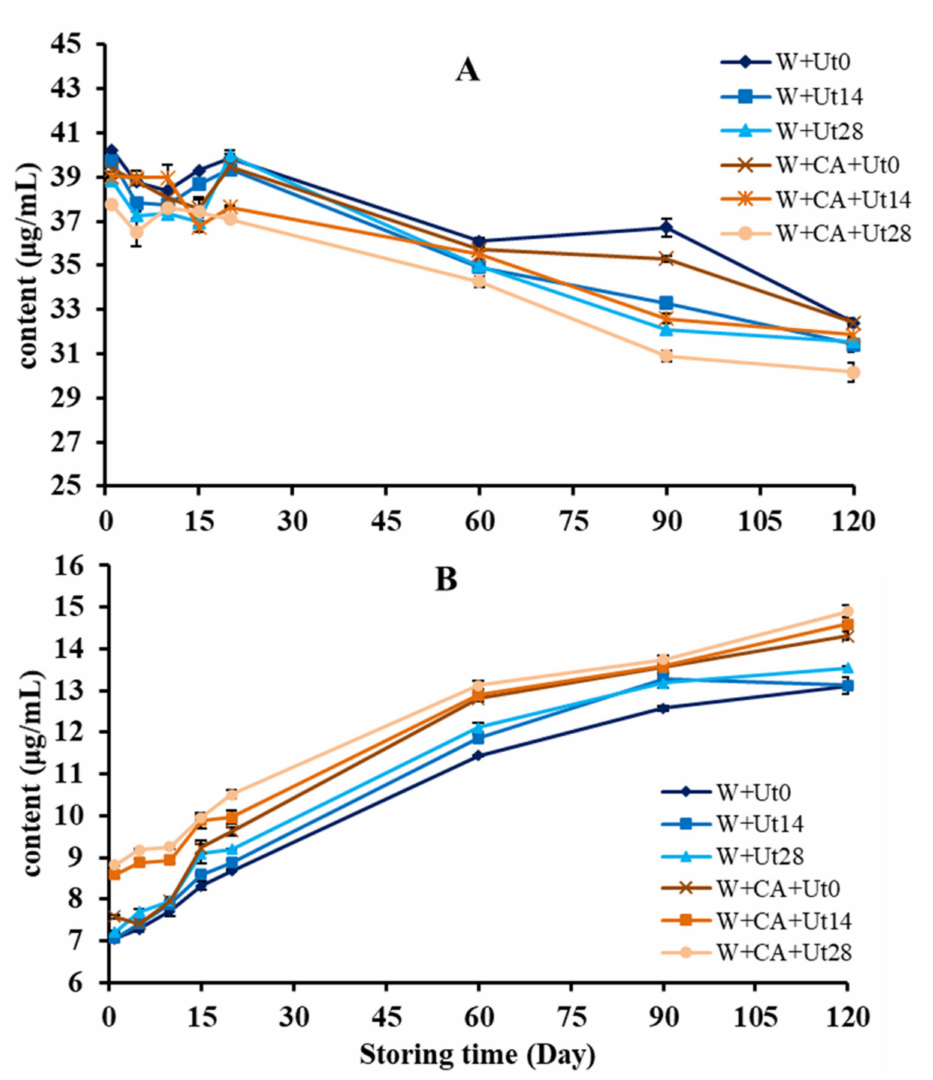
Figure 5. Evolutions of malvidin-3-O-glucoside ( A ) and syringic acid ( B ) in wine samples during